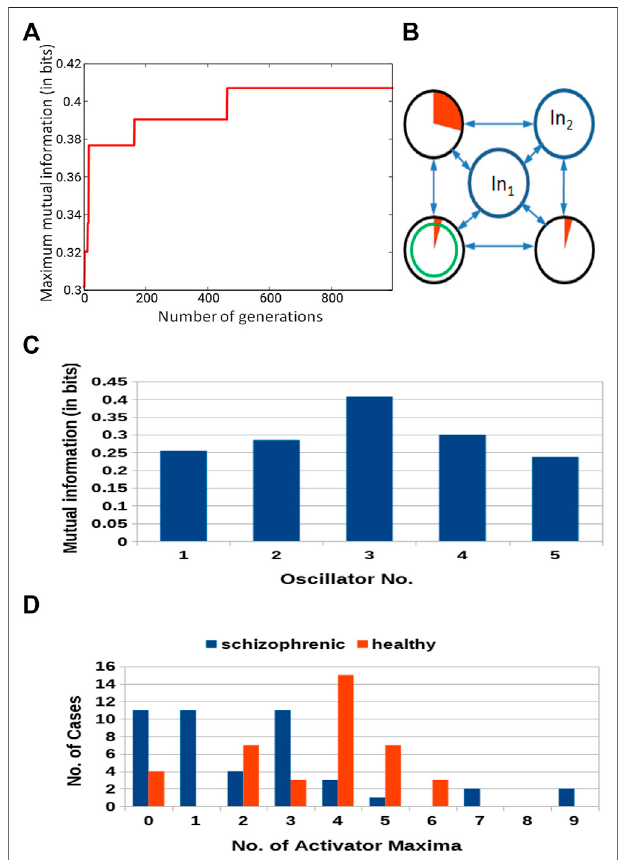
FIGURE 9 | Results for 5-oscillator network (cf. Figure 2C ): (A) The progress of optimization; the Fitness as a function of generation number. (B) The structure of the optimized network. Notation as in Figure 5B . (C) The mutual information I ( G ; O j ) for j ∈ {1,2,3,4,5}. The function j → I ( G ; O j ) has the maximum at j =3. (D) The distribution of the numbers of cases for which a given number of activator maxima was observed on oscillator # 3 for records representing schizophrenic and healthy patients.